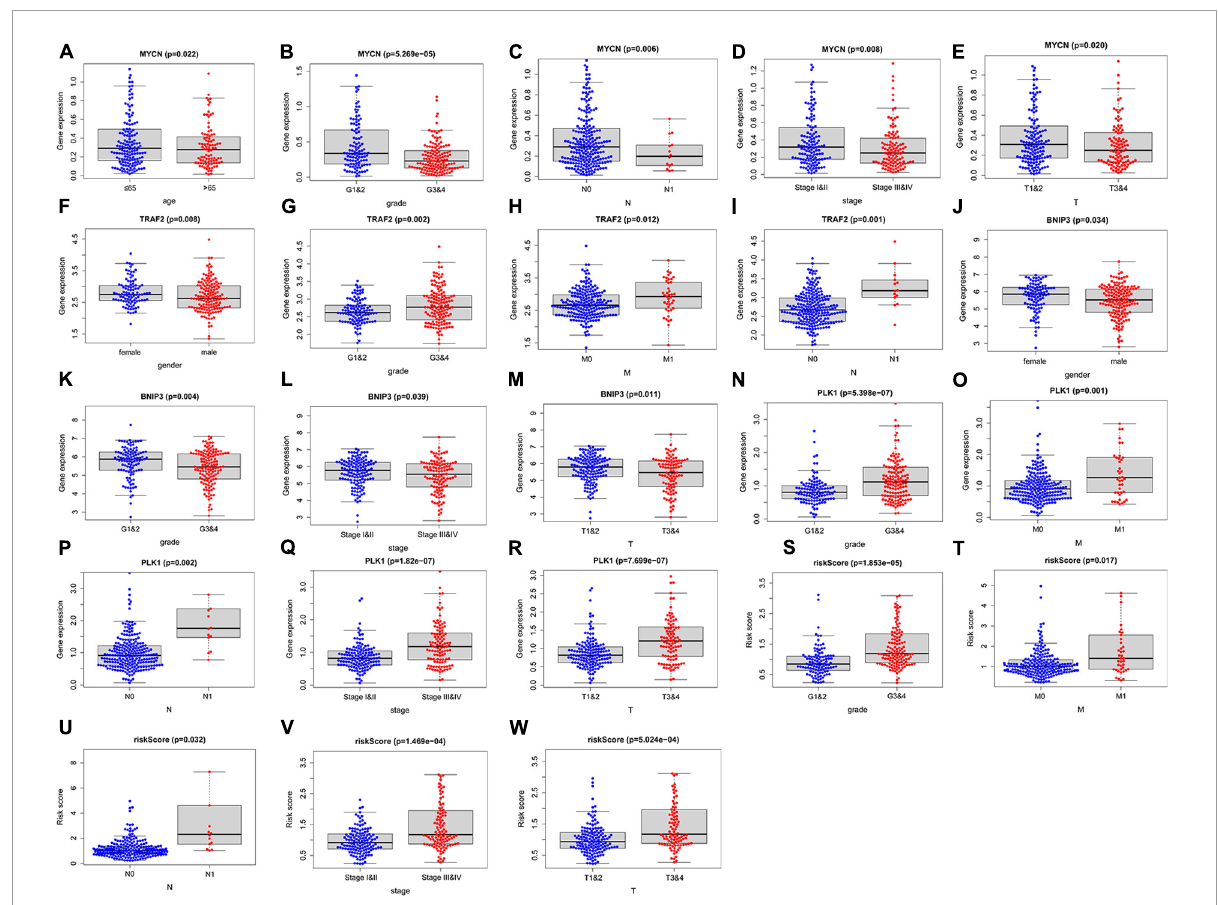
FIGURE7 Correlation between the 4 NRGs, necroptosis-related prognostic signature and clinical factors. The expression of MYCN in different groups with different age (A) grade (B) , N (C) , stage (D) , T (E) ; the expression of TRAF2 in different groups with distinct sex (F) , grade (G) , M (H) , N (I) ; the expression of BINP2 in different groups with different sex (J) , grade (K) , stage (L) , T (M) ; the expression of PLK1 and risk-score in different groups with different grade (N,S) M (O,T) , N (P,U) , stage (Q,V) , T (R,W)